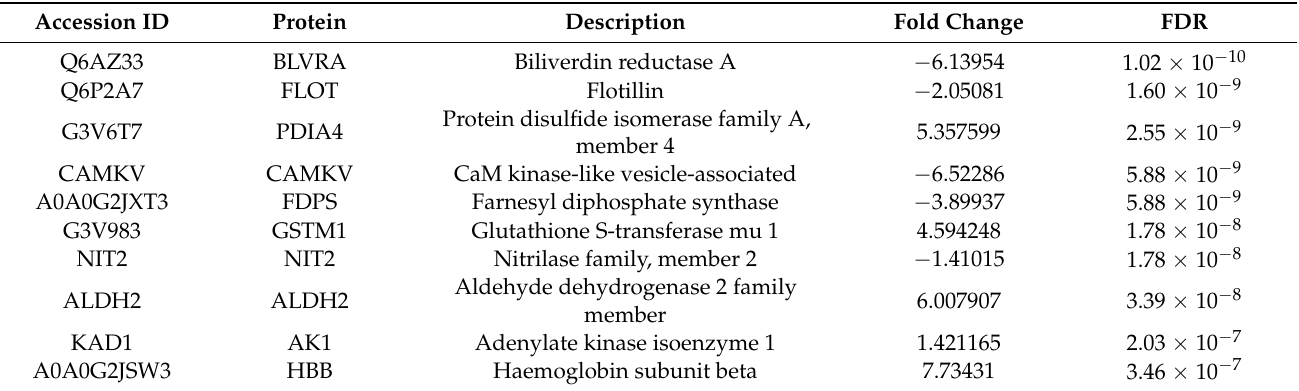
Table 1. The top 10 differentially expressed proteins identified in the somatosensory cortex of the GAERS compared to the NEC